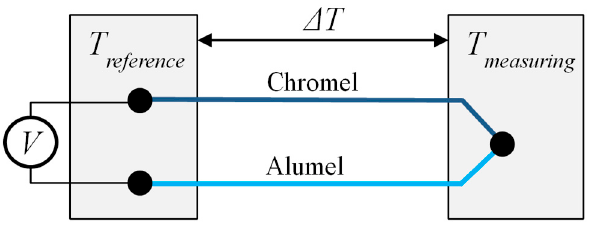
Figure 25 . Principle DWTS on a turbine blade.